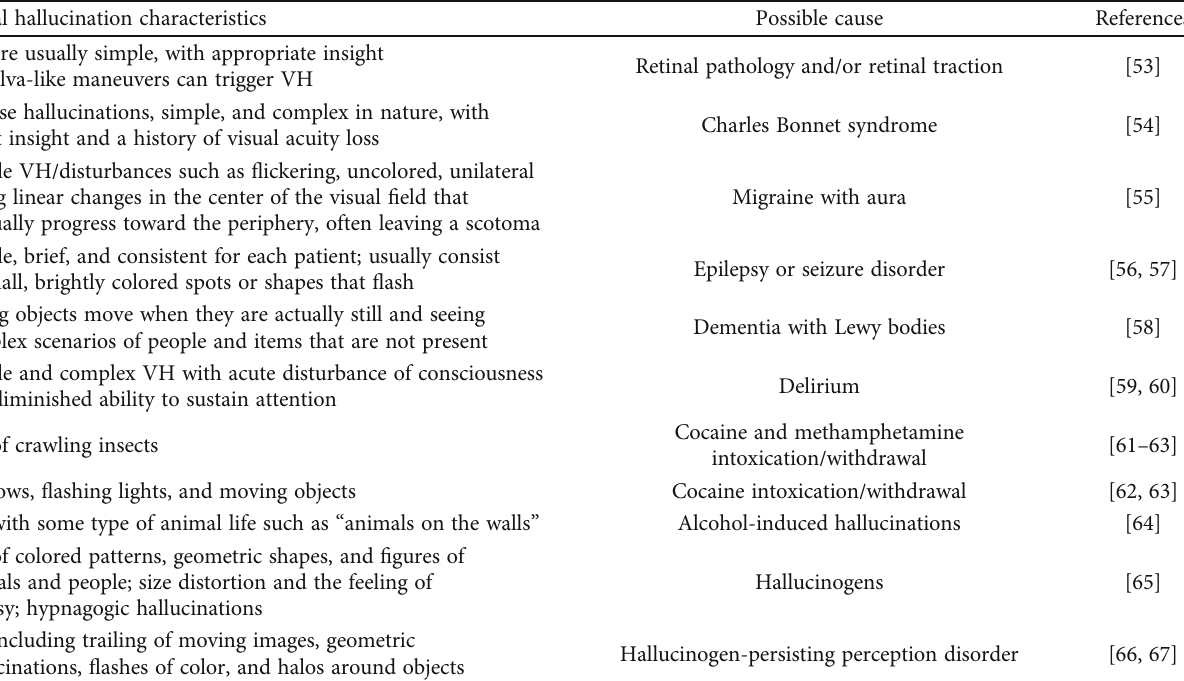
Table 2: Di ff erential diagnosis of visual